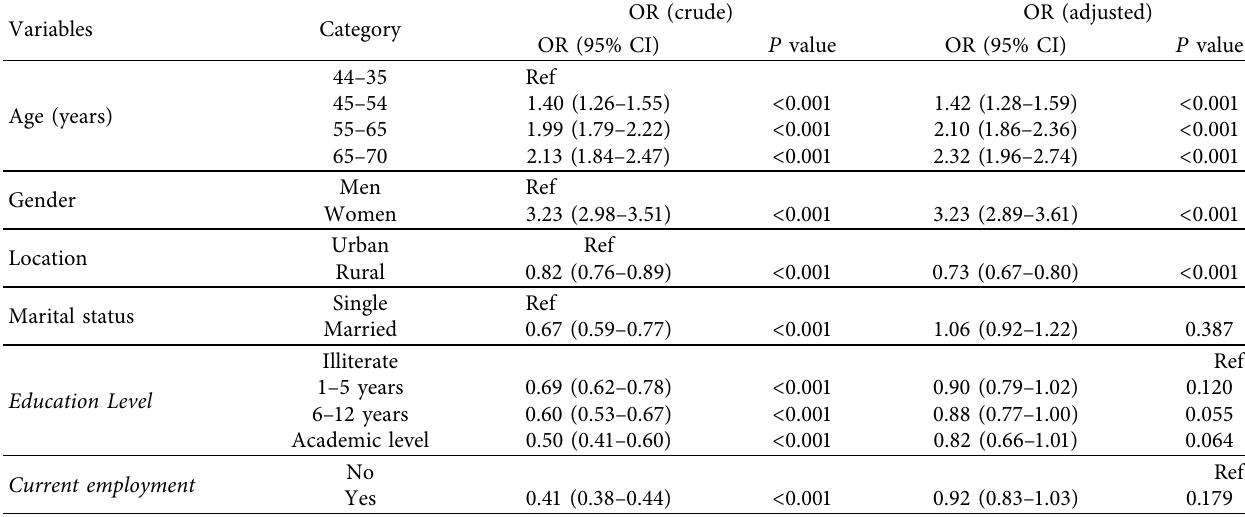
Table 3: The relationship between metabolic syndrome and demographic characteristics in single and multivariate regression analyses.